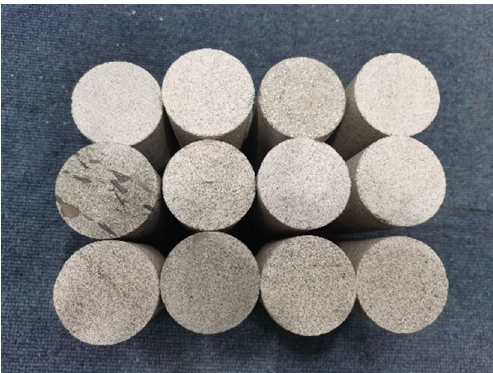
Figure 1. Part of sandstone